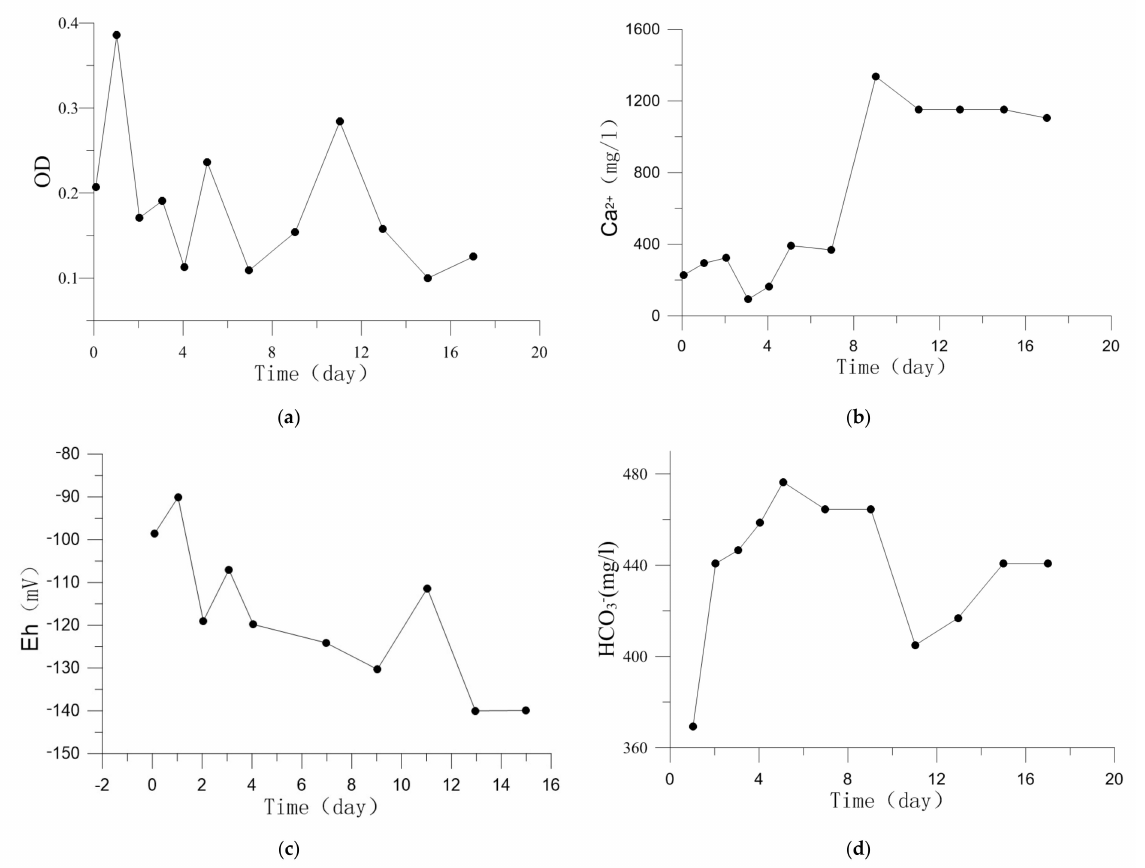
Figure 3. Fluid chemistry change during the experiment. ( a ) OD. ( b ) Ca 2+ concentrations. ( c ) Eh. ( d ) HCO 3 −